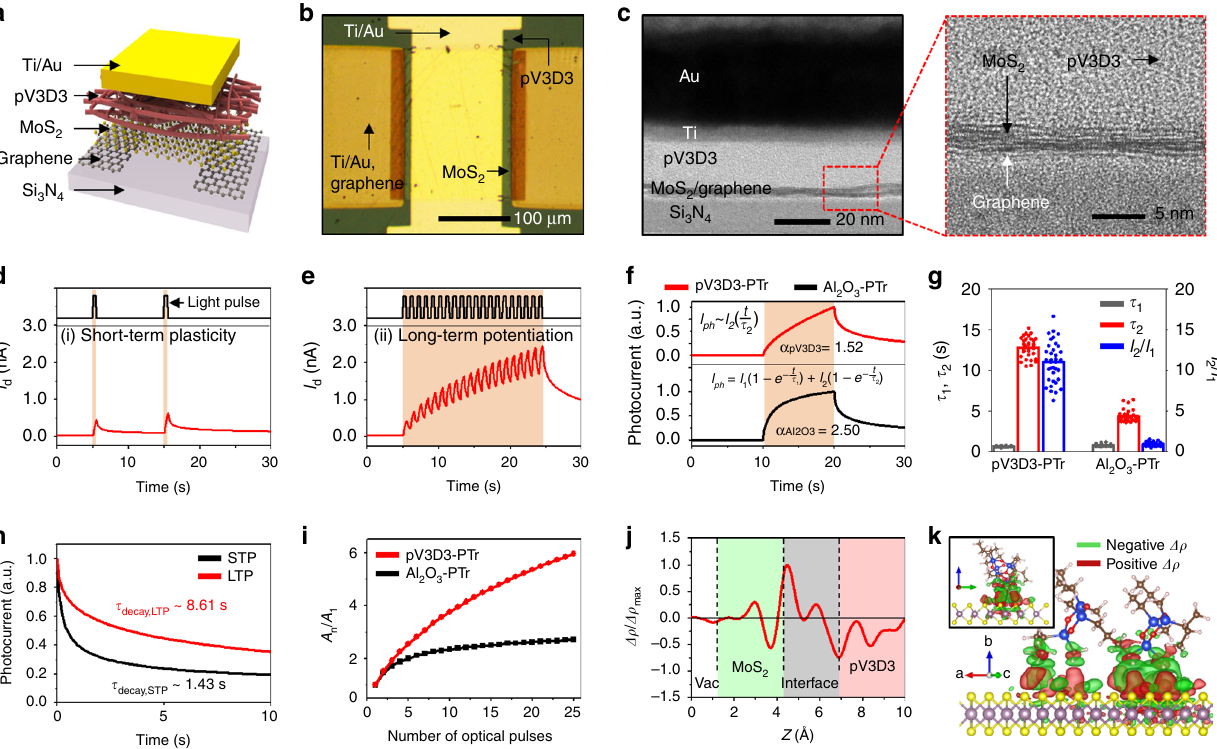
Fig. 2 Photon-triggered neuromorphic behavior of the MoS 2 -pV3D3 phototransistor. a Schematic illustration of the device structure of pV3D3-PTr. b Optical microscope image of pV3D3-PTr. c Cross-sectional TEM images of pV3D3-PTr (left) and its magni fi ed view (right). d , e Photon-triggered STP ( d ) and LTP ( e ) of pV3D3-PTr. f Photocurrent generation and decay characteristics of pV3D3-PTr and Al 2 O 3 -PTr. g Statistical analyses ( N = 36) of time constants ( τ 1 , τ 2 ) and ratio of the photocurrent coef fi cient ( I 2 / I 1 ) for pV3D3-PTr and Al 2 O 3 -PTr. h , Photocurrent decay characteristics of pV3D3-PTr. For STP, a single optical pulse with 0.5 s duration was applied. For LTP, 20 optical pulses for 0.5 s duration each with 0.5 s intervals were applied. i A n / A 1 of pV3D3-PTr and Al 2 O 3 -PTr as a function of the number of applied optical pulses. j Computationally obtained plane-averaged interfacial charge density difference in the MoS 2 -pV3D3 heterostructure (i.e., Δρ = ρ MoS2,B − ρ MoS2 − ρ B where the subscript B indicates the dielectric) versus the distance in the aperiodic lattice direction. k Contour plots of the charge density difference in planes normal to the interface in the MoS 2 -pV3D3 heterostructure. The green and red contours imply potential hole trapping and electron trapping sites, respectively. The inset shows a side view of Fig.